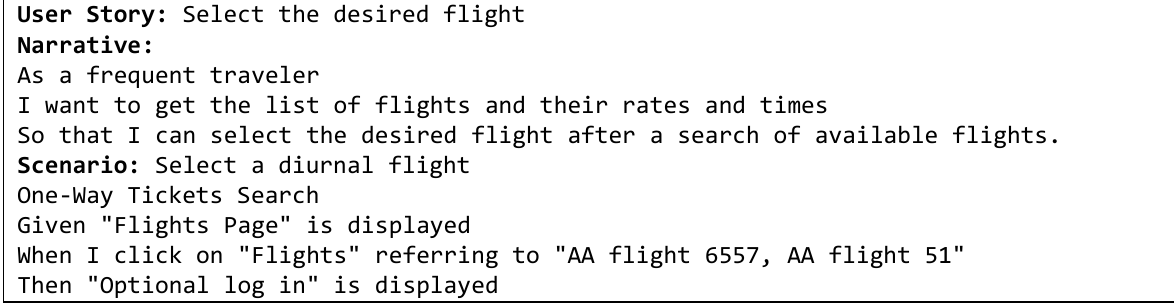
Figure 11. User Story for Select the desired flight formatted for the testing template